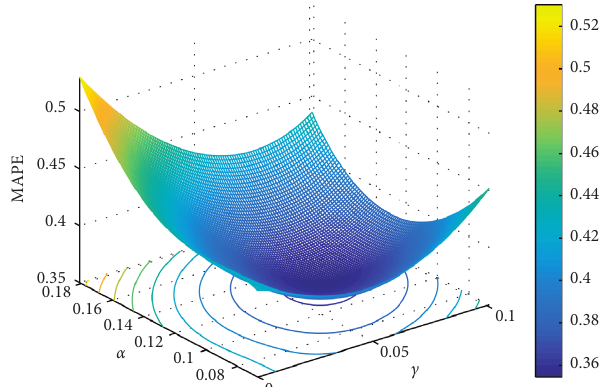
Figure 2: The relationship between MAPE and parameters.